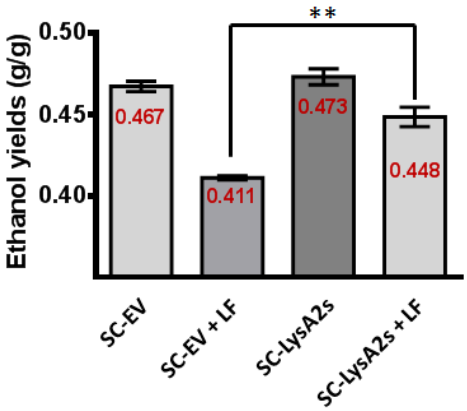
Figure 4. Impact of LysA2 secretion by S. cerevisiae on ethanol yield. In YPD60, the ethanol yield of S. cerevisiae secreting LysA2 (SC-LysA2s) showed 5% increase compared with S. cerevisiae with the empty vector (SC-EV) when L. fermentum (LF) is present. This result is significantly different. ** < 0.01.